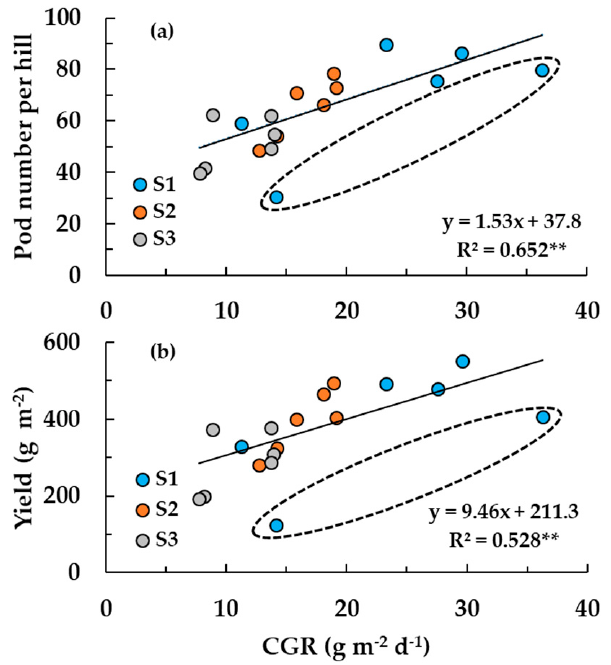
Figure 6. Relationships of crop growth rate (CGR) with pod number per hill ( a ) and yield ( b ). S1, S2, and S3 refer to sowing dates on 10–15 June, 25–30 June, and 10–15 July, respectively. Two dots within an ellipse with dotted line refer to data from flooded S1 plots at R2 (flowering) in 2020. ** p < 0.01.